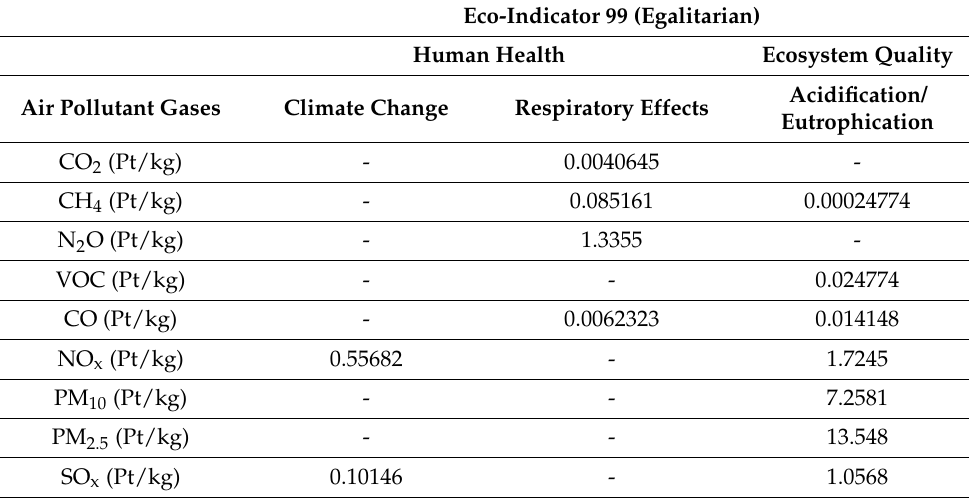
Table 3. Egalitarian Eco-Indicator 99 Weighting